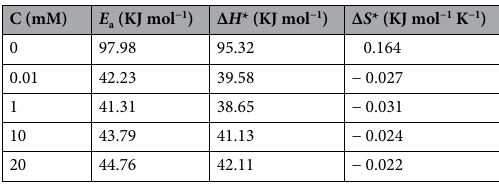
Table 3. Activation parameters of MS in 5% HCl.